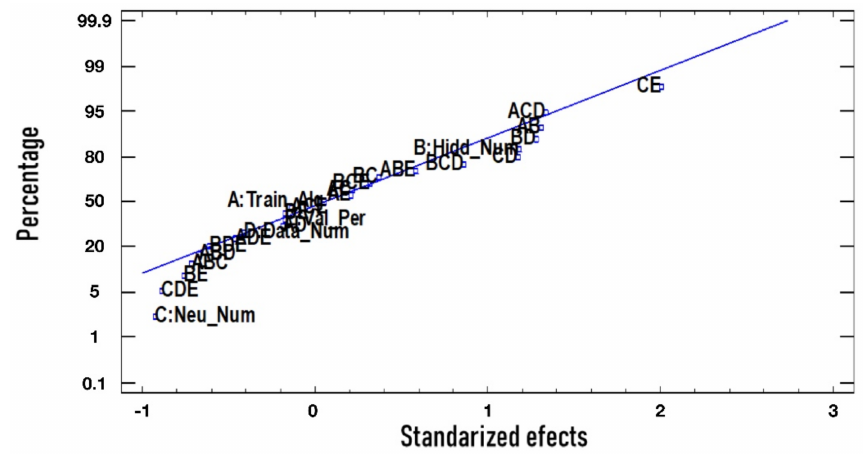
Figure 1. Normal probability plot for Akaike information criterion (AIC).